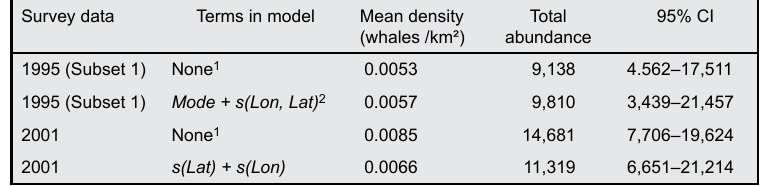
Table 4. Comparison of the models, predicted mean densities (whales /km²) and 95% boot- strap CI for the survey region common to 1995 and 2001 surveys (size of common region is 1,725,204 km²) using models fitted to either the 1995 or 2001 survey data. s (.) denotes inclu- sion of the covariate as a smooth function in the model. Survey